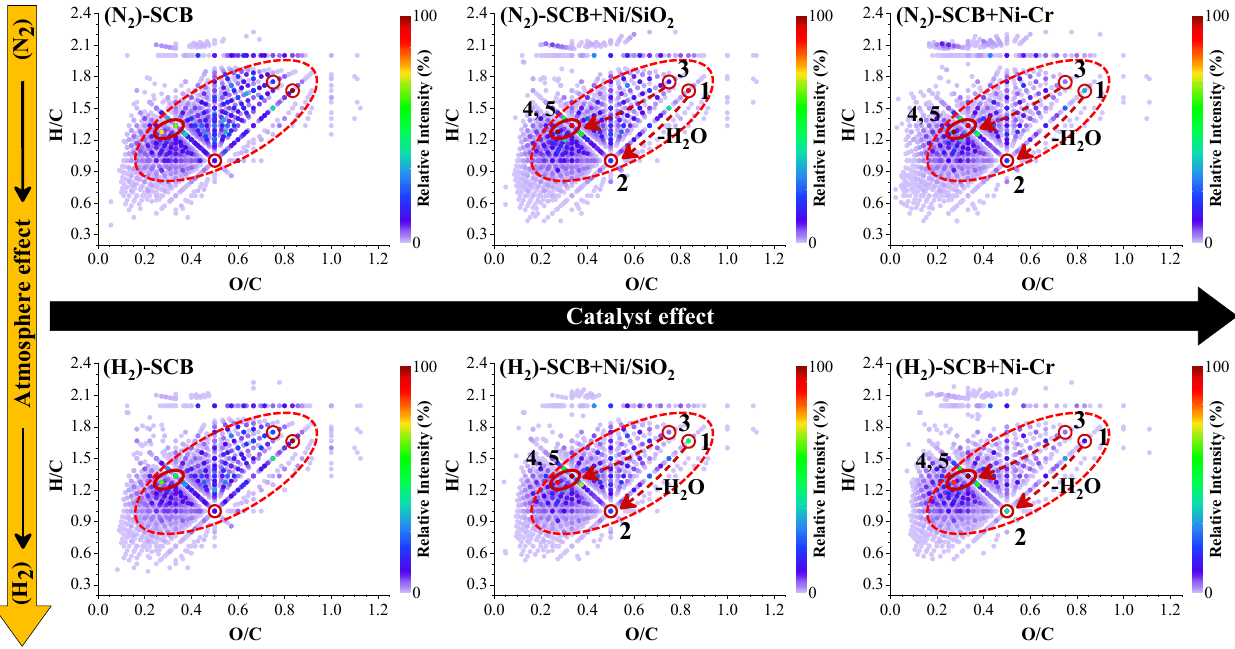
Figure 6. van Krevelen diagrams for the classes of Ox-type compounds (x = 2–11) analyzed by HESI(+)-FT-Orbitrap MS.